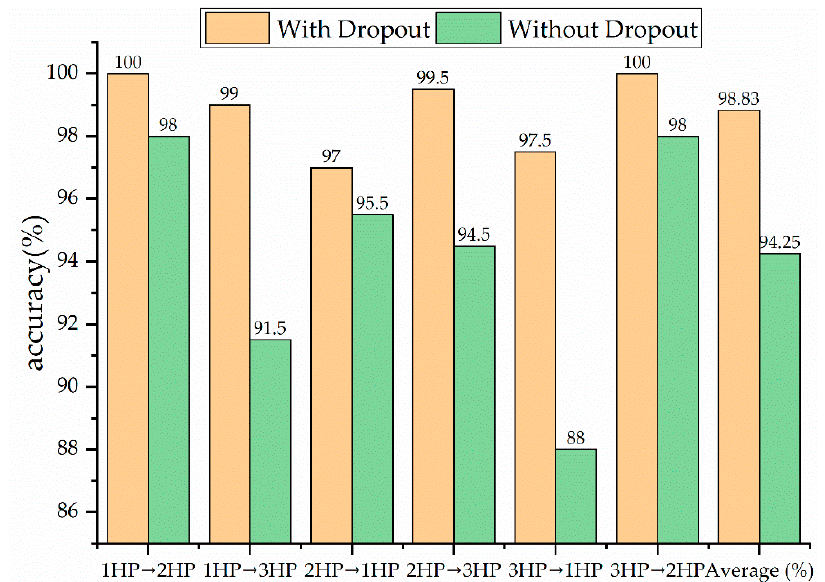
Figure 12. Under different loads with Dropout and without Dropout.